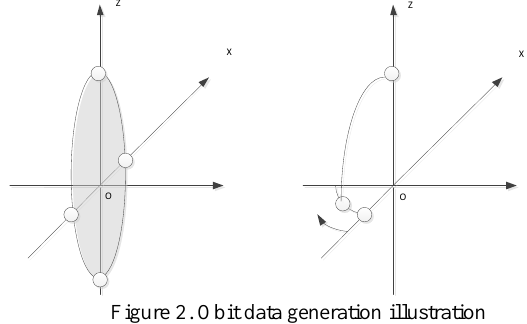
Figure 2. Obit data generation illustration